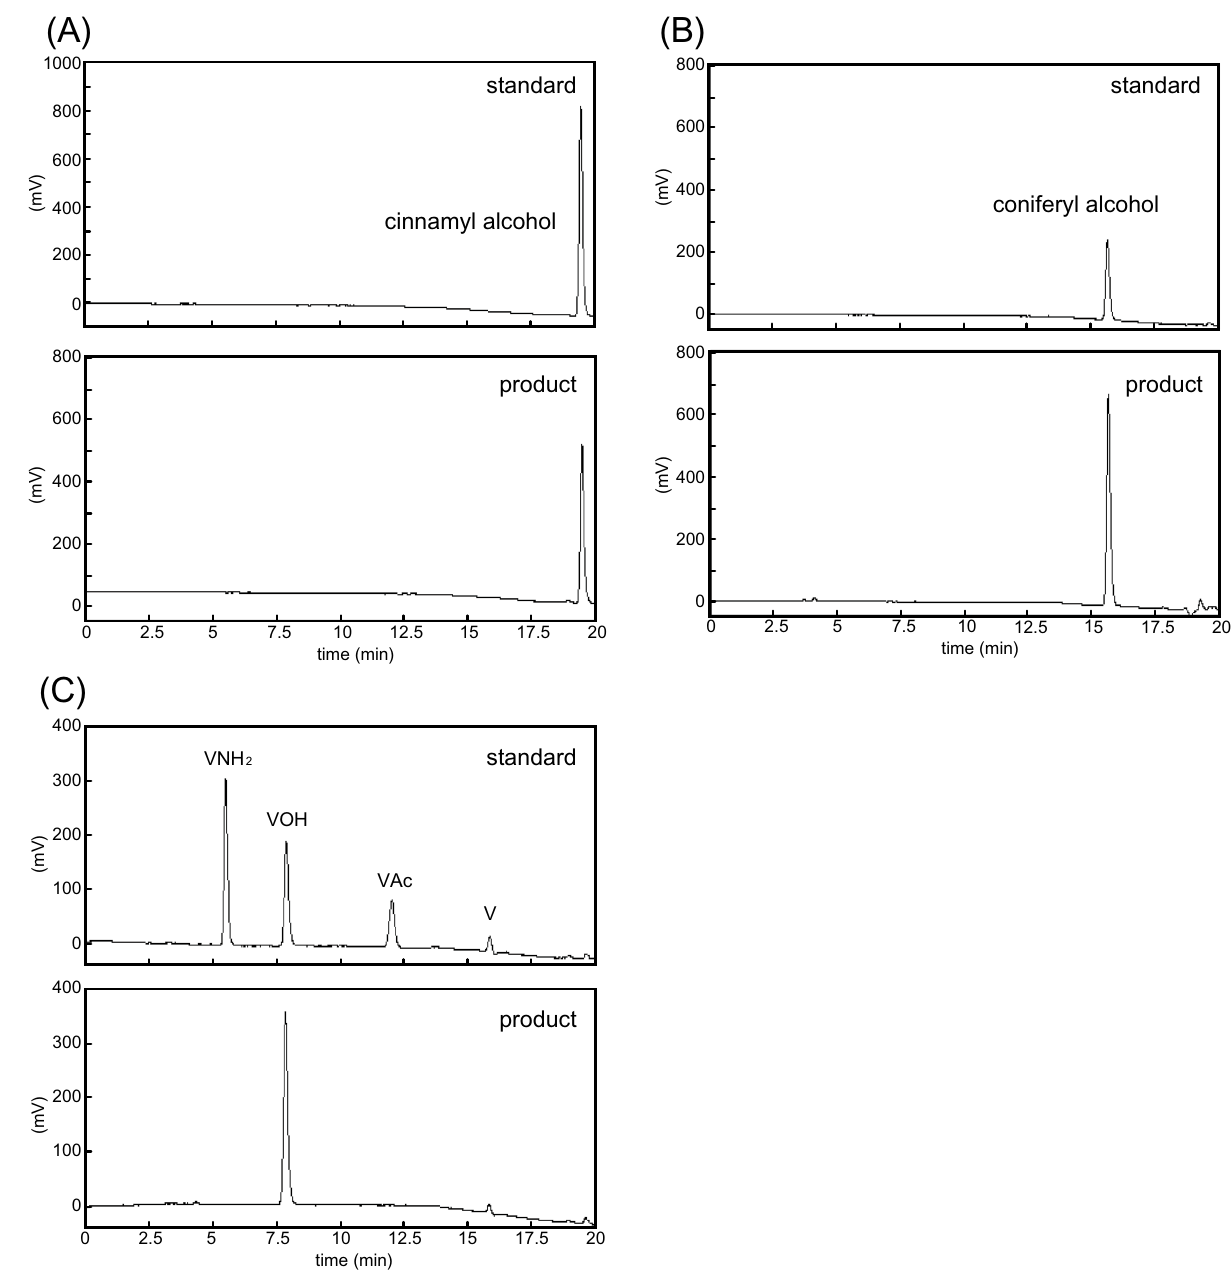
Figure 5. HPLC chromatograms of the products of reactions between rCaCAD1 and several substrates. Chromatograms for the products of the reactions between rCaCAD1 and ( A ) cinnamaldehyde, ( B ) coniferyl aldehyde, and ( C ) vanillin are presented. The components in the reaction mixture were analyzed by HPLC (fluorescence detection: 280 nm excitation wavelength and 320 nm emission wavelength). The HPLC chromatograms for the following standards are provided (top): ( A ) cinnamyl alcohol, ( B ) coniferyl alcohol, and ( C ) vanillin derivatives (V: vanillin; VOH: vanillyl alcohol; VNH 2 : vanillylamine; and VAc: vanillic acid). After a 30-min reaction, the products were analyzed by HPLC (bottom). Cinnamaldehyde, coniferyl aldehyde, and vanillin were hardly detectable at this wavelength, which explains the lack of peaks for the unreacted